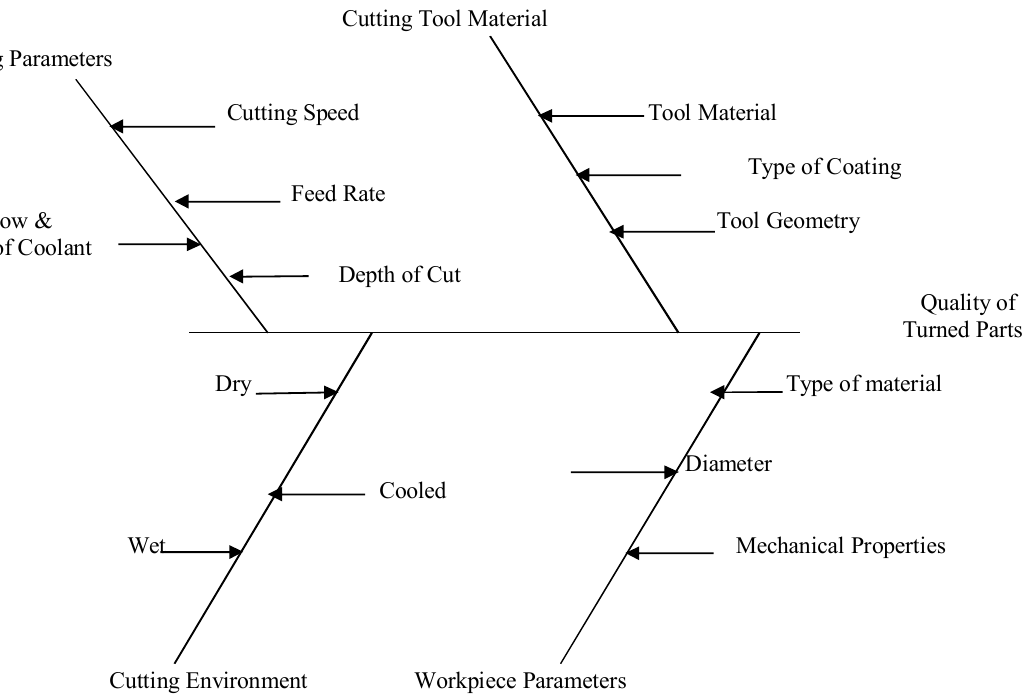
Table 2. The surface roughness of the turned surface is measured using a Tokyo Seimitsu Surfcom 130A type instrument. The instrument is set to a cutoff length of 0.8 mm with a transverse length of 4 mm. A tool holder SVJCR steel EN47 is used during the turning operation.